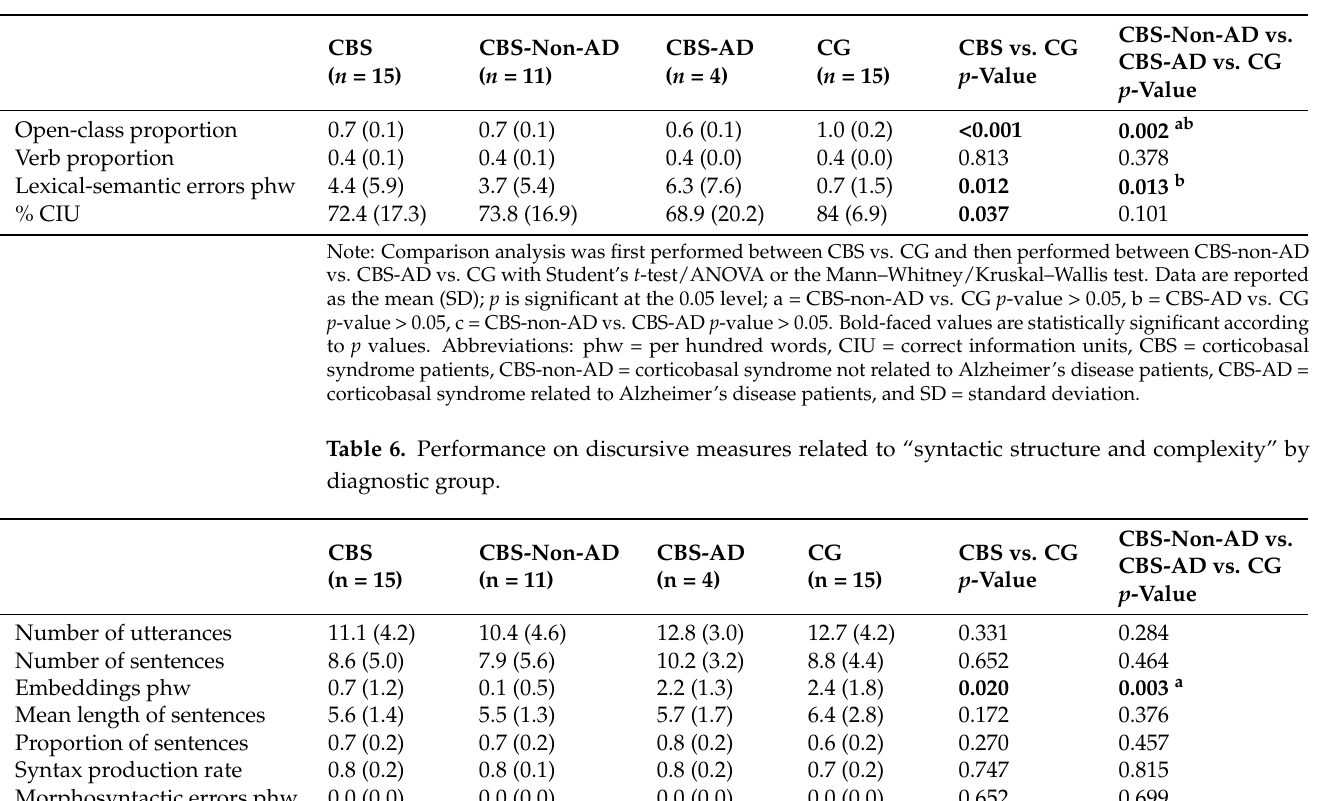
Table 5. Performance on discursive measures related to “lexical-semantic level” by diagnostic group.